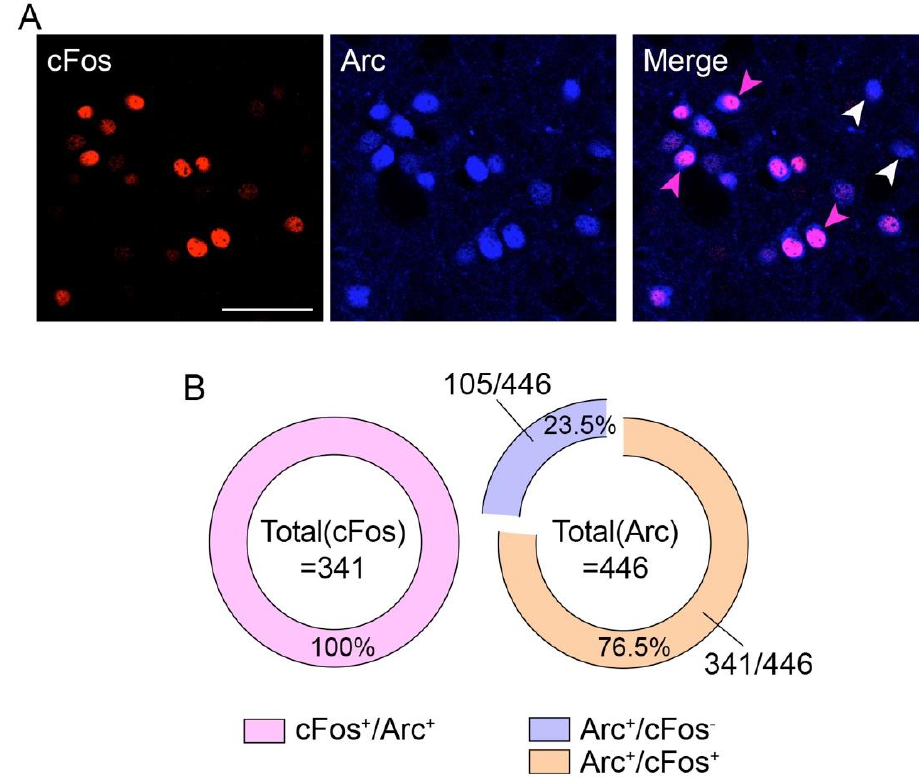
Figure 2. Spatiocellular organization of haloperidol-induced cFos and Arc. ( A ) Double immunofluorescence detection of cFos (red) and Arc (blue) following haloperidol administration. Scale bar: 50 μm. Arrows in magenta indicate the co-expression of cFos and Arc in the same neurons, whereas arrows in white indicate the expression of Arc (no cFos co-expression). ( B ) Quantification of the degree of colocalization between cFos and Arc. Note that 23.5% of Arc + -neurons did not express cFos.